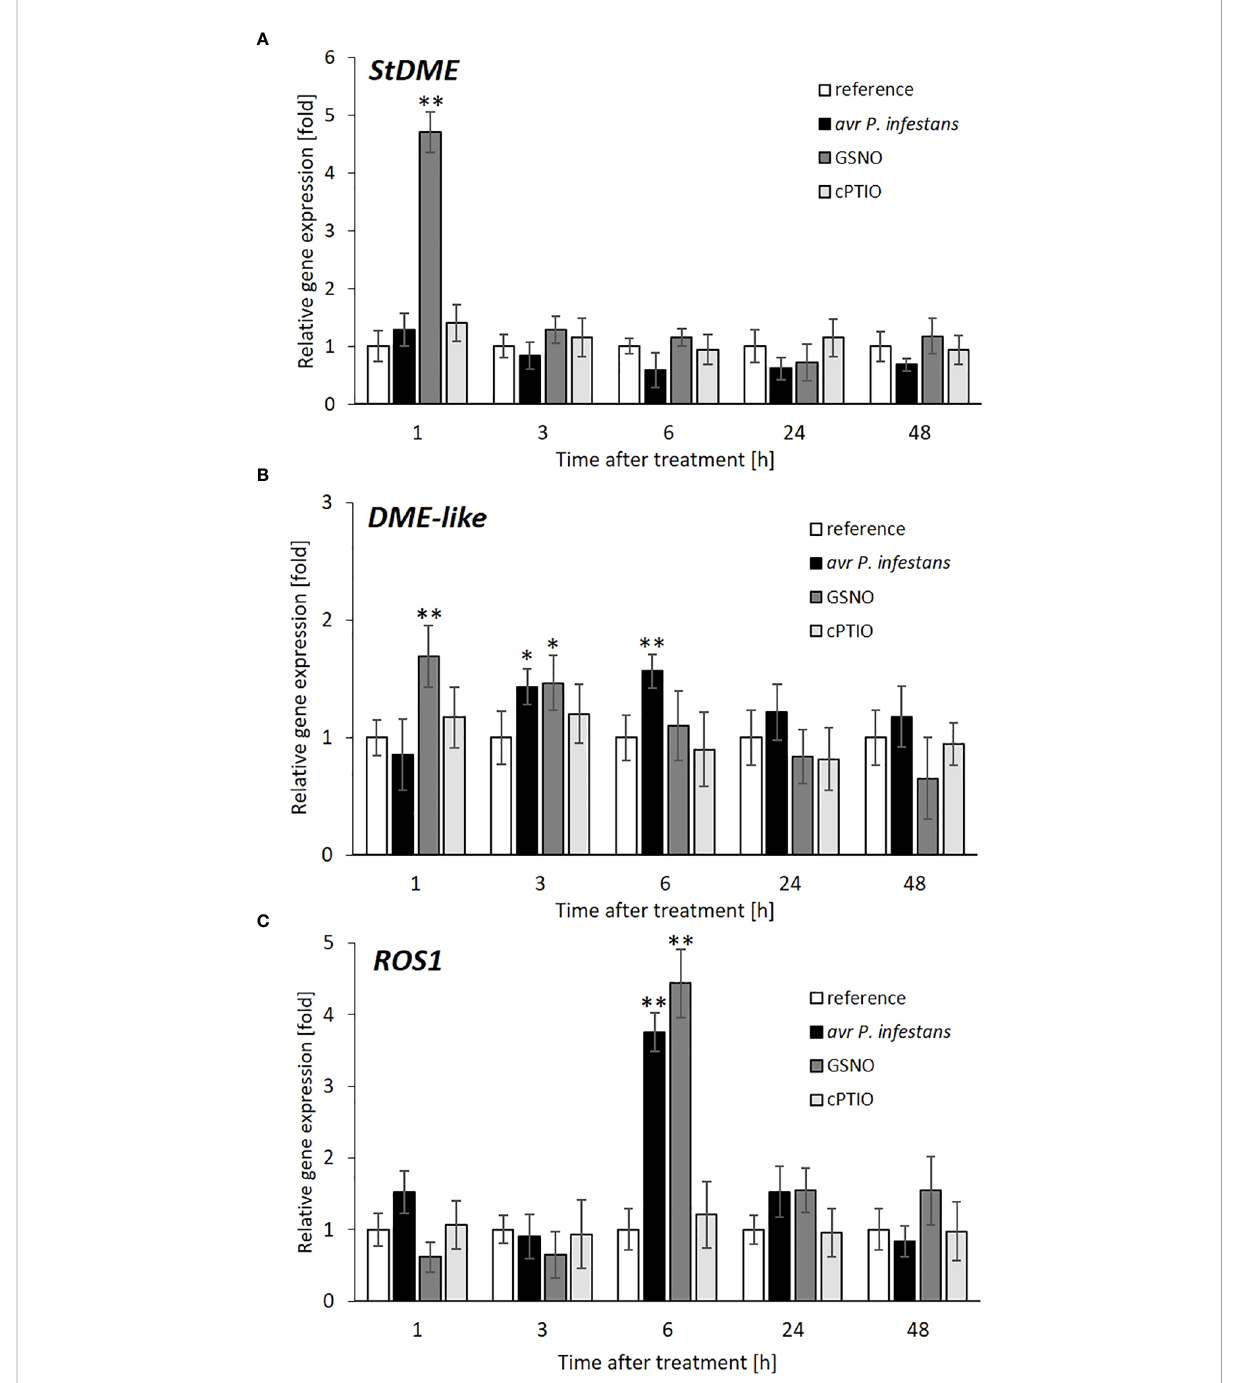
FIGURE 7 DNA demethylase gene expression after pathogen or GSNO treatment. RT-qPCR analyses of the StDME (A) , DME - like (B) , and ROS1 (C) , respectively, were performed at selected time points at 1-48 h after GSNO, cPTIO treatment, or challenge inoculation. There were no signi fi cant changes in the absolute values of the analyzed transcript levels after the leaves spraying with water. Values represent the means of data ± SD of at least three independent experiments. Asterisks indicate values that differ signi fi cantly from water-treated (reference) potato leaves at a <0.05 ( ∗ ) and a <0.01 ( ∗∗